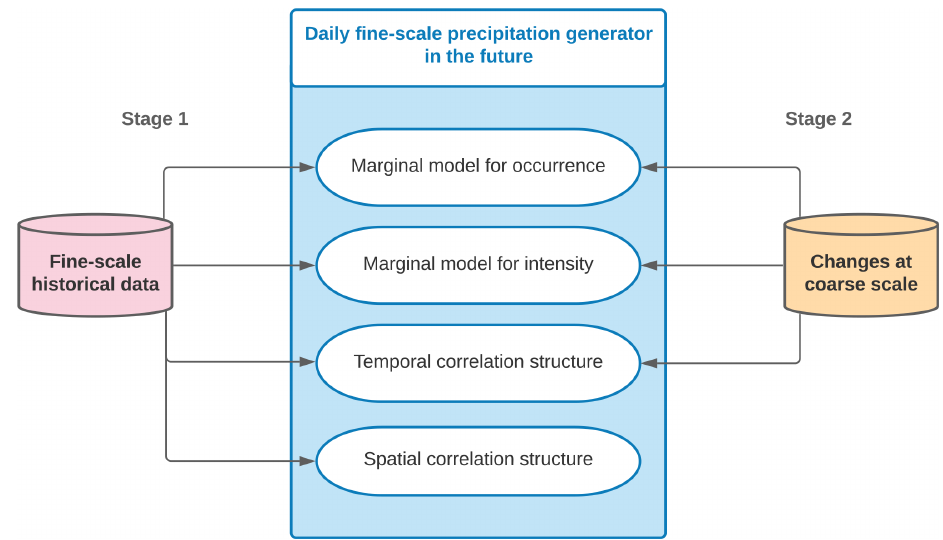
Figure 1. The proposed two-stage weather generator approach for simulations of fine-scale daily precipitation in a future